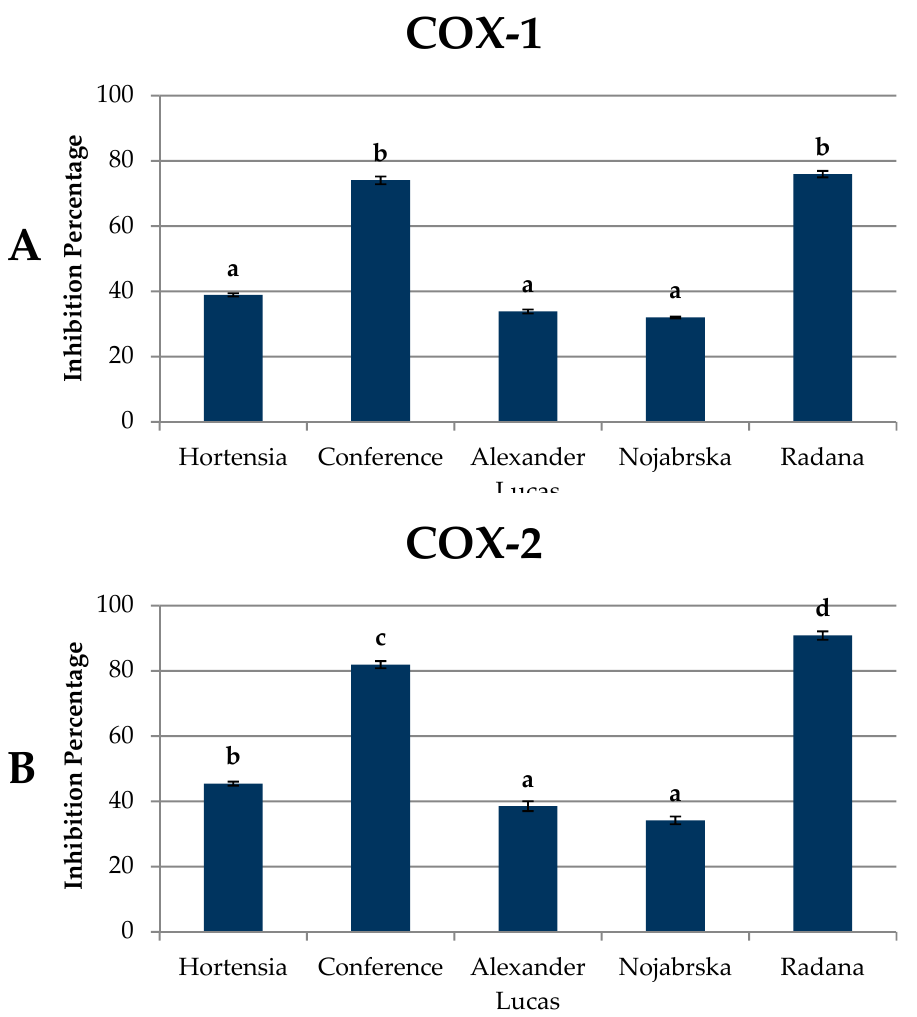
Figure 6. Anti-inflammatory activity of pear fruits (% of inhibition) against ( A ) cyclooxygenase-1 (COX-1) and ( B ) cyclooxygenase-2 (COX-2) enzymes. Varieties with di ff erent letters were significantly di ff erent at p = 0.05 according to Duncan’s test. The data are expressed as mean ± SD ( n = 9).